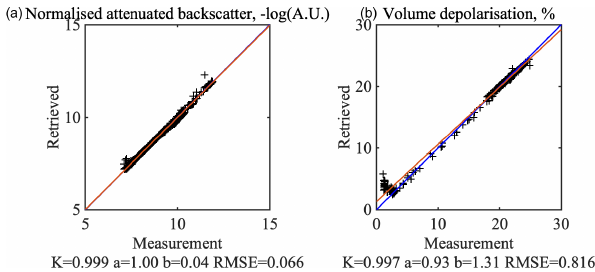
Figure 16. Achieved attenuated normalized backscatter (a) and vol- ume depolarization (b) fits for the multi-temporal retrievals per- formed on 15–16 April